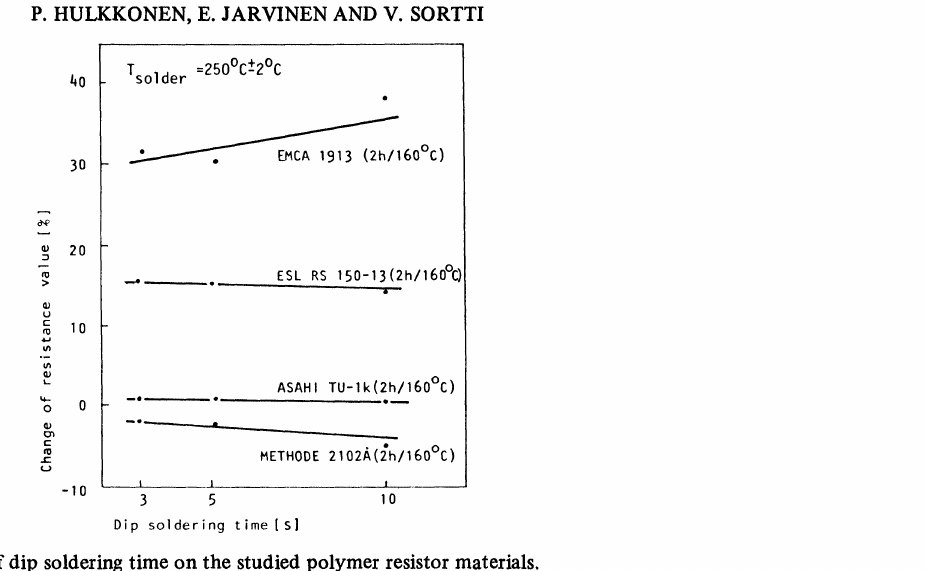
-----5 i0 Dip soldering time [S] FIGURE 5 Effect of dip soldering time on the studied polymer resistor materials. results from the soldering temperature test. This test indicates that the resistance changes take place very quickly after the resistor is immersed into the solder bath and the resis- tance keeps its new changed value independent on the length of time in the solder